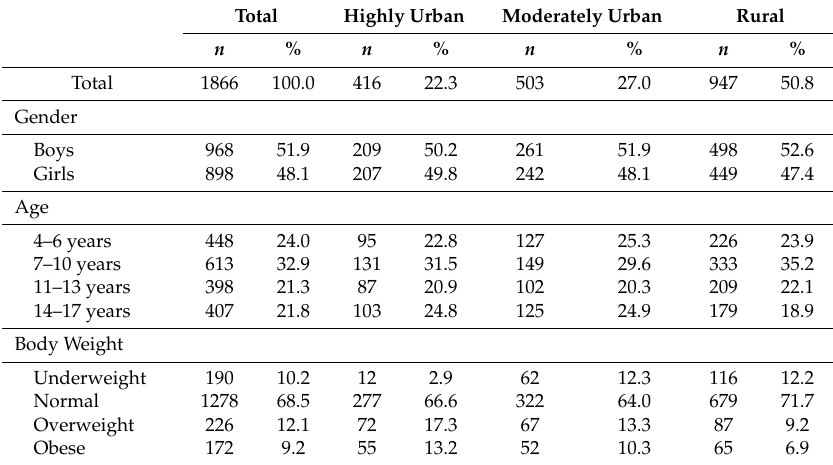
Table 1. Characteristics of surveyed children by community types, CHNS